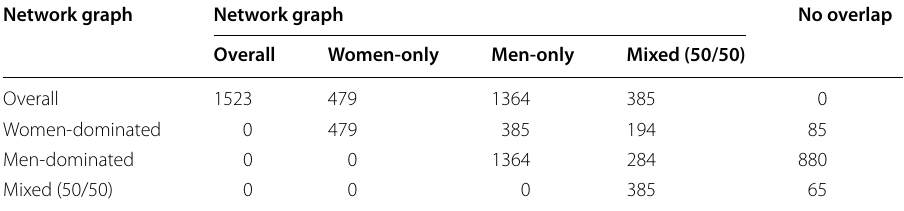
Table 8 Connectedness of festivals per gendered community for second operationalization Network